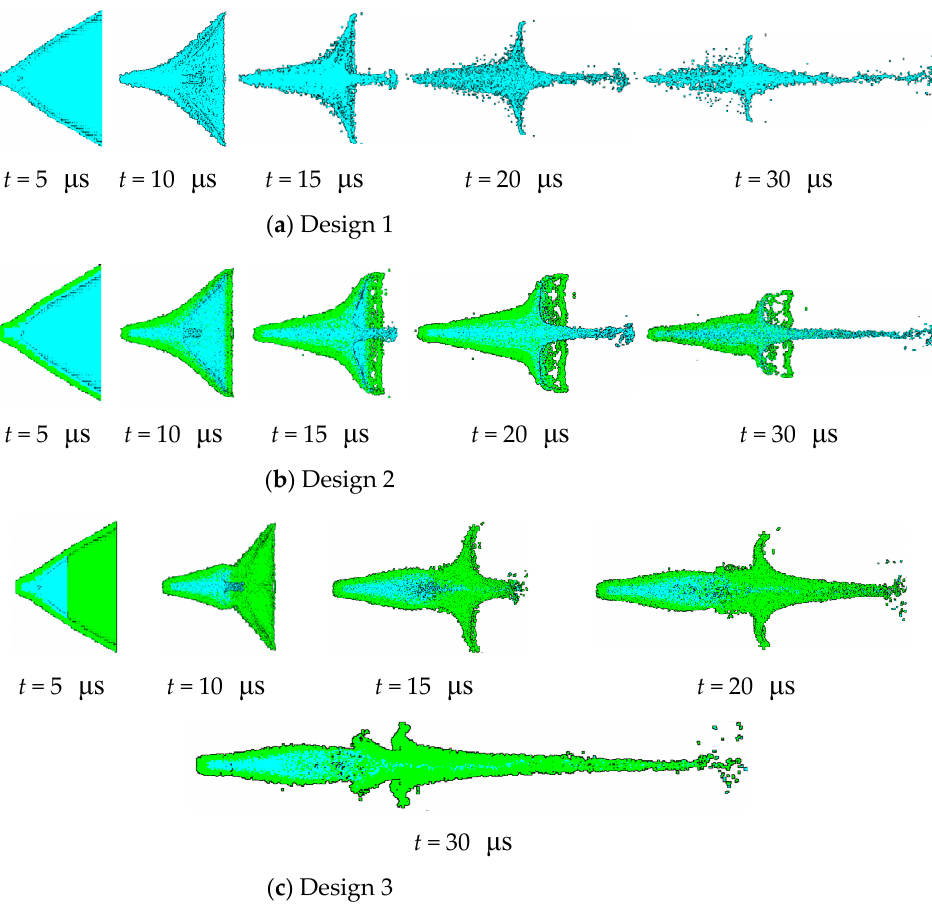
Figure 13. Jet formation by simulations for design 1~3 ( a – c ).